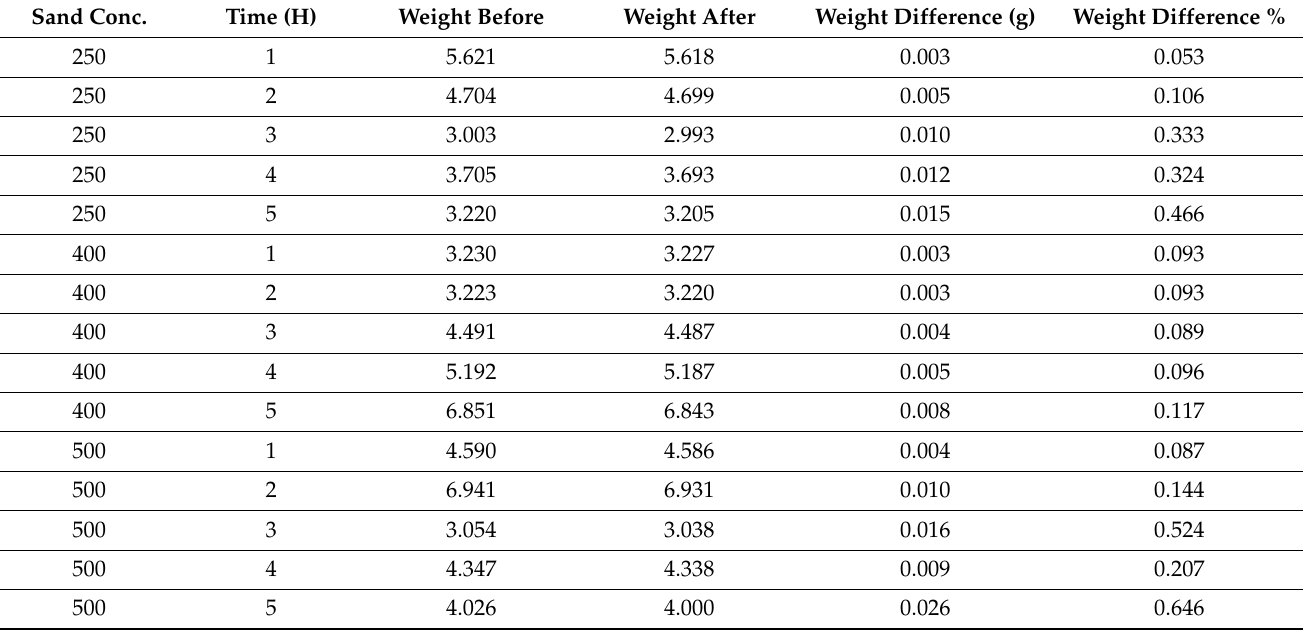
Table 2. Test data at a flow rate of 0.0067 m 3 /min.